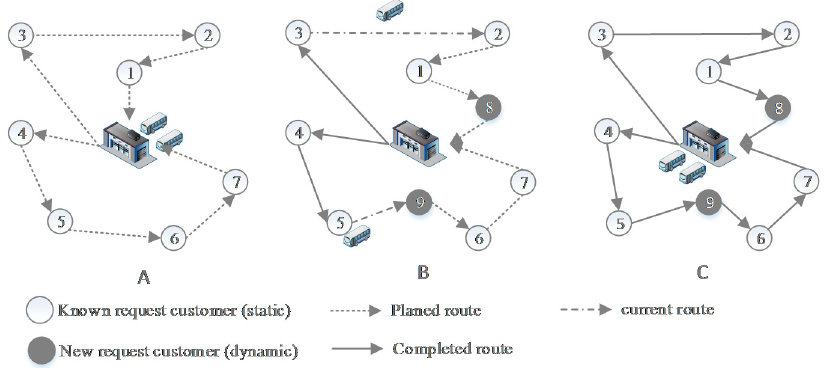
Figure 1. An illustration of a typical dynamic vehicle routing problem.